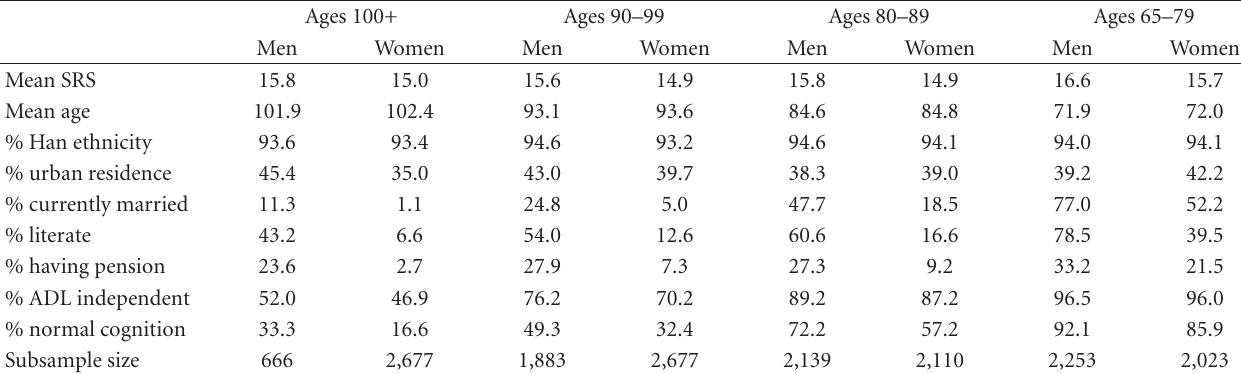
Table 3: Descriptive statistics of the variables investigated in this